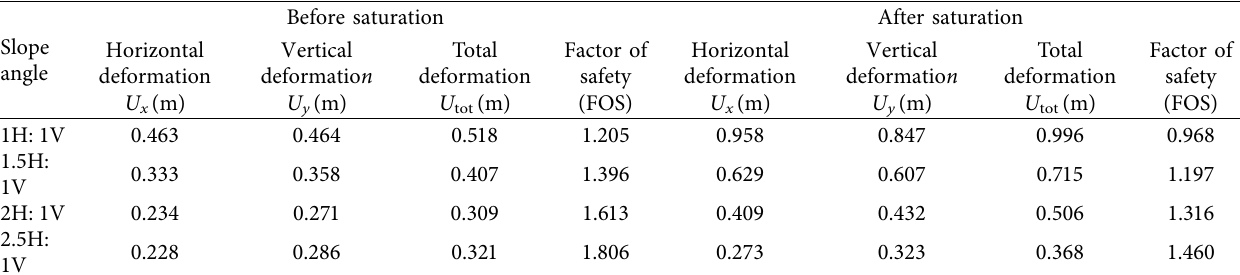
Table 6: FOS and slope deformation values for slope-5 by Plaxis 2D before and after saturation. Before saturation After saturation Slope Horizontal angle deformation